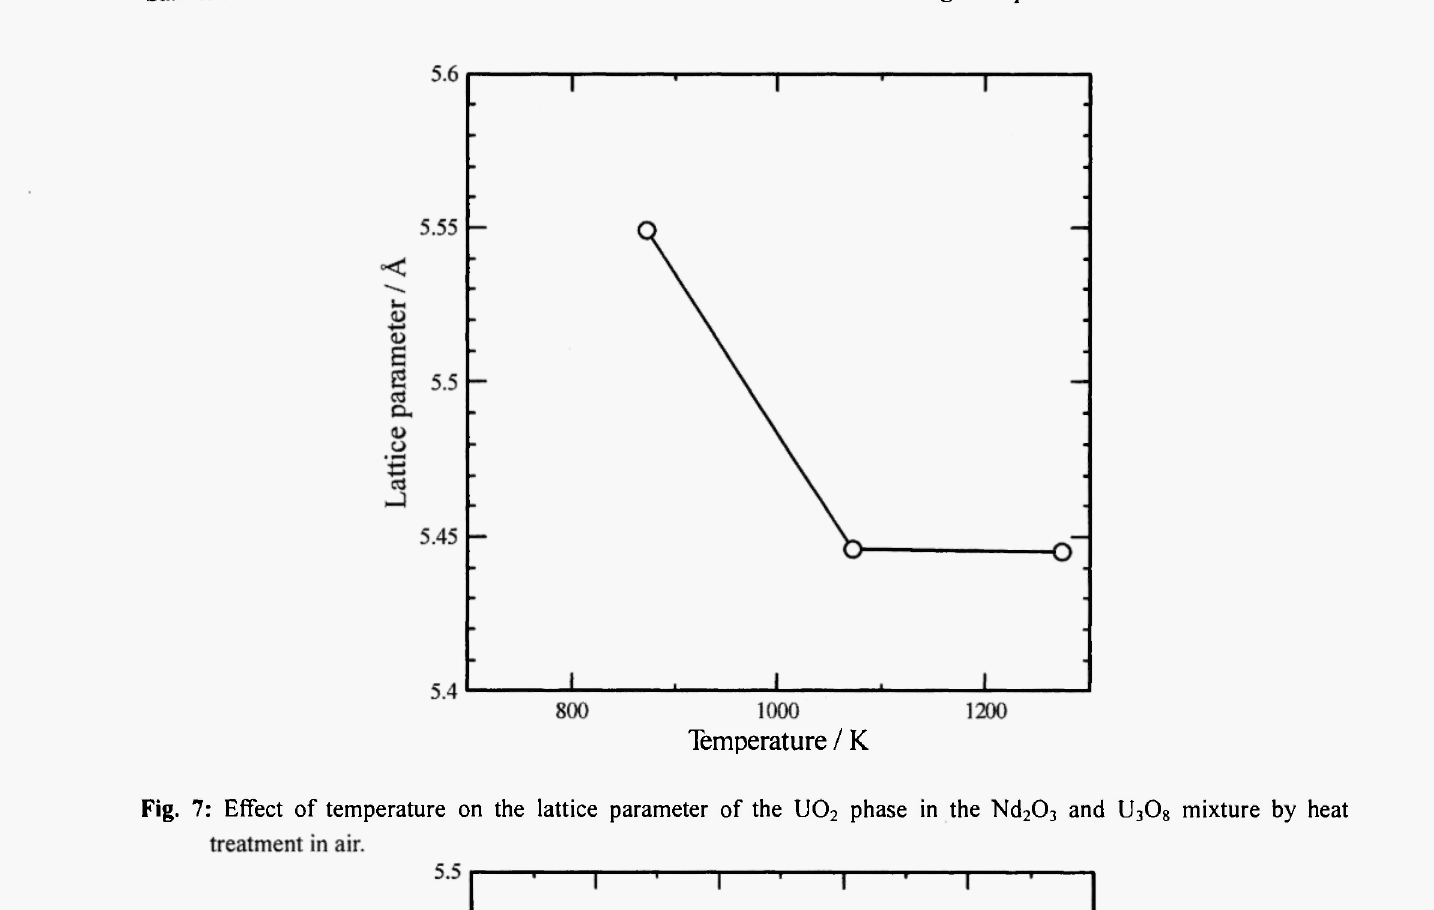
Fig. 7: Effect of temperature on the lattice parameter of the U0 2 phase in the Nd 2 0 3